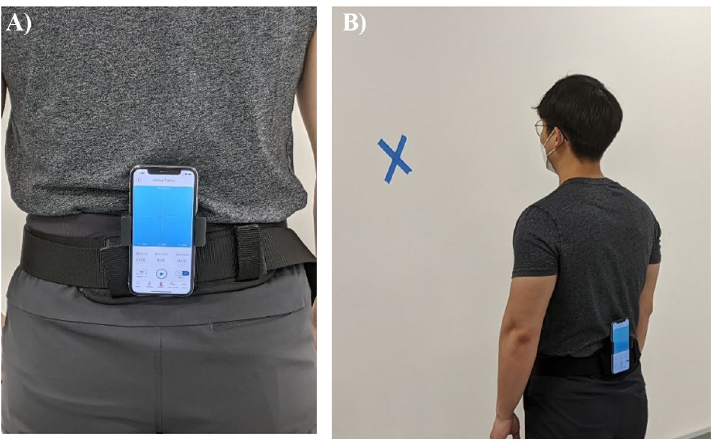
Figure 1. ( A ) A smartphone was affixed in the participant’s lumbar region for the in-clinic walking speed and postural stability assessments. ( B ) All participants were required to perform postural stability testing for 60 s with eyes open and closed. The cross on the wall provided a visual cue for the